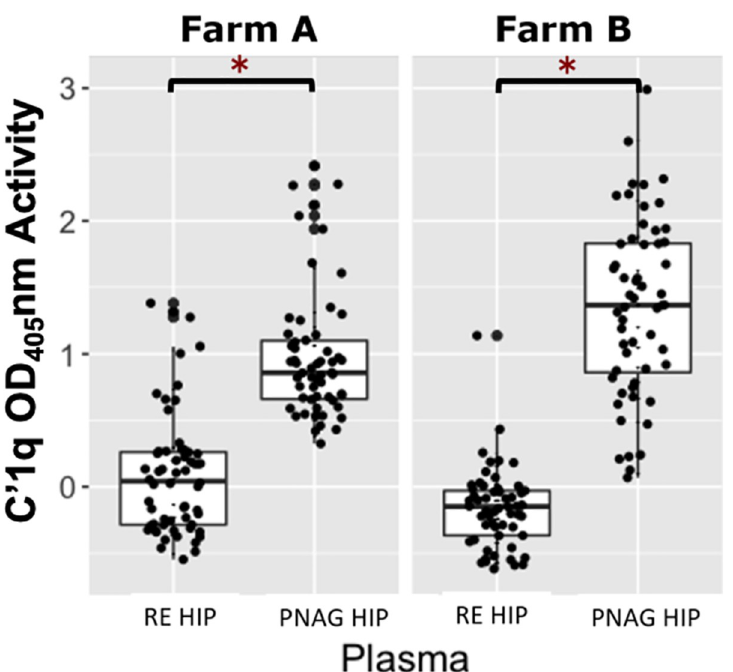
Fig 3. Comparison of C ՛ 1q relative optical density between R . equi hyperimmune plasma and PNAG hyperimmune plasma. Boxplot of relative optical density (OD 405 nm) activities for deposition of complement component 1 (C ՛ 1q) onto PNAG by serum antibodies in 119 foals from Farm A and 114 foals from Farm B, stratified by plasma type, faceted by farm. Foals transfused with PNAG hyperimmune plasma (PNAG HIP) at both farms had significantly higher (asterisks represent P < 0.05) C ՛ 1q OD 405 nm activities than foals that were transfused with R . equi hyperimmune plasma (RE HIP). The mean (95% CI) OD activity of C ՛ 1q antibodies among foals at Farm A and B were 0.98 (0.85 to 1.11) and 1.35 (1.17 to 1.53), respectively among foals transfused with PNAG HIP and were 0.09 (-0.03 to 0.21) and -0.17 (-0.24 to 0.09), respectively, among foals transfused with PNAG